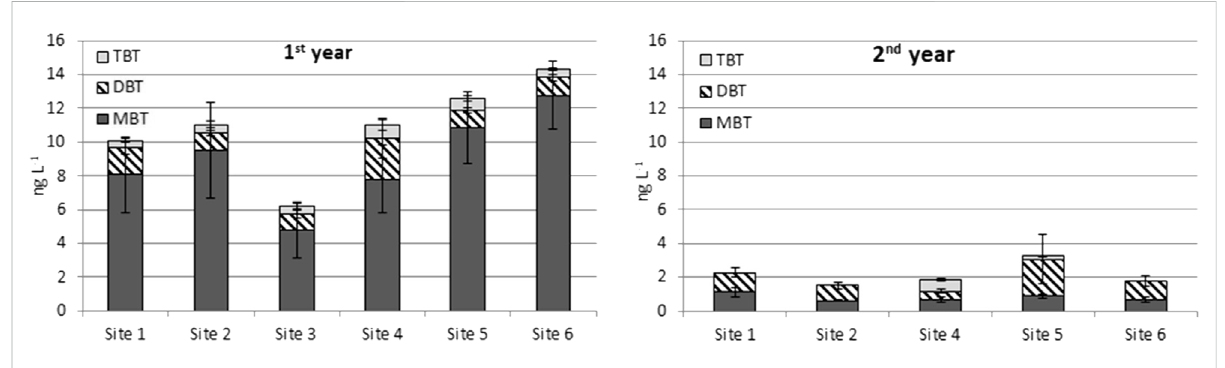
FIGURE 2 Average BTC concentrations in grab water